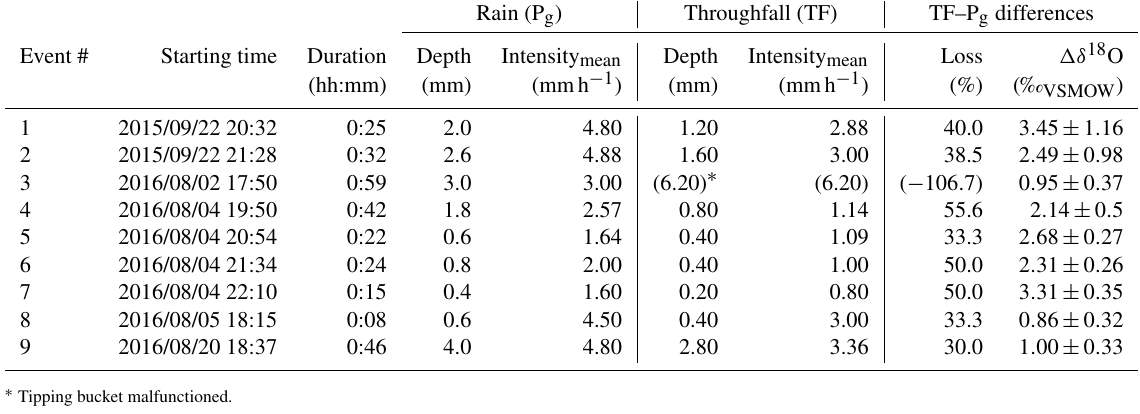
Table 1. Depth, mean intensity, and isotope values of continuously sampled P g and TF. Data of (cid:49)δ 18 O are reported as mean ± SD.